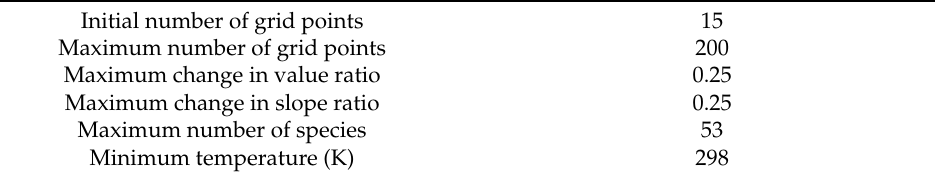
Table 4. PDF table